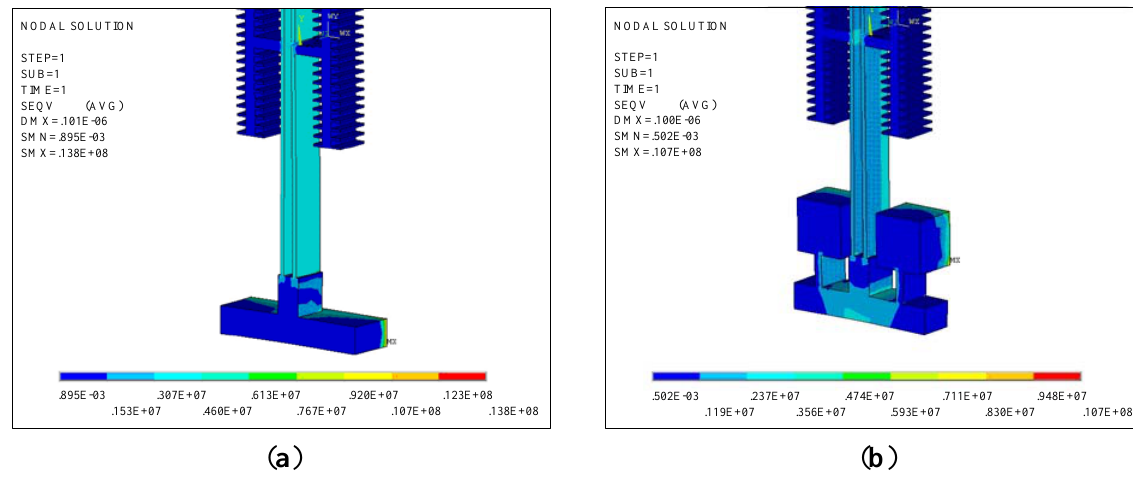
Figure 5. The stress distributions of the two DETF structures when the ambient temperature increases from room temperature to +60 °C; ( a ) The common DETF structure, ( b ) The improved DETF structure.